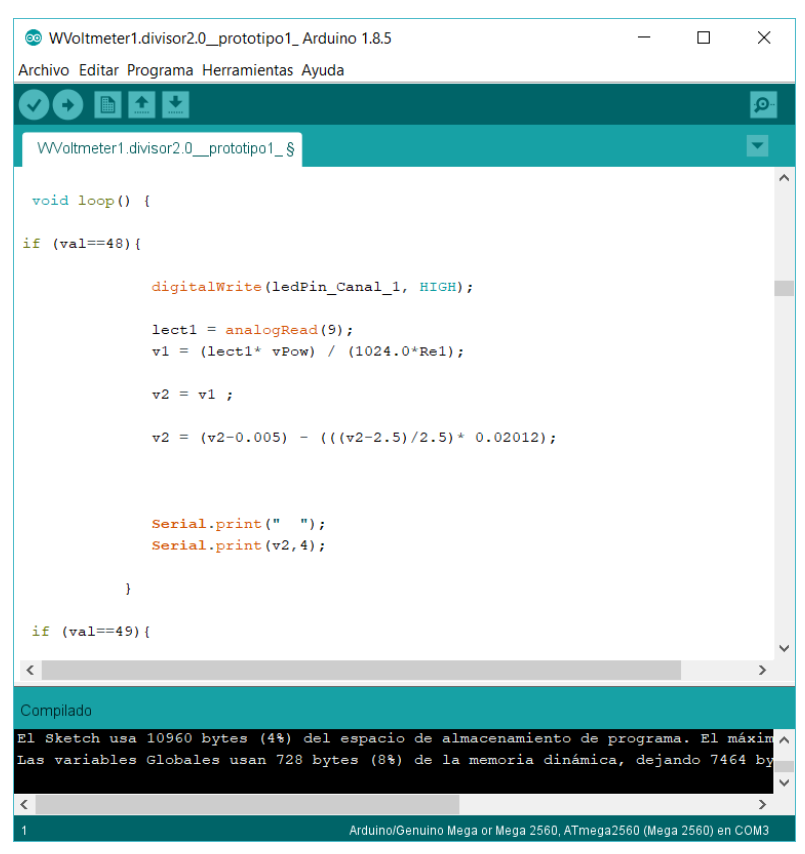
Figure 6. Image capture with part of the ABDAS software control program code.